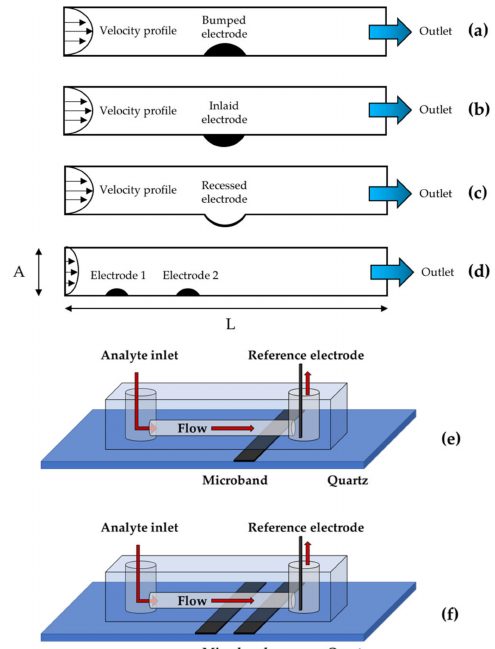
Figure 1. Cross sections of the channel geometries with one bumped ( a ), inlaid ( b ), or recessed ( c ) electrode and two bumped electrodes ( d ). Schemes of the devices containing single ( e ) and two-microbands electrode ( f ) (Working electrode not shown).